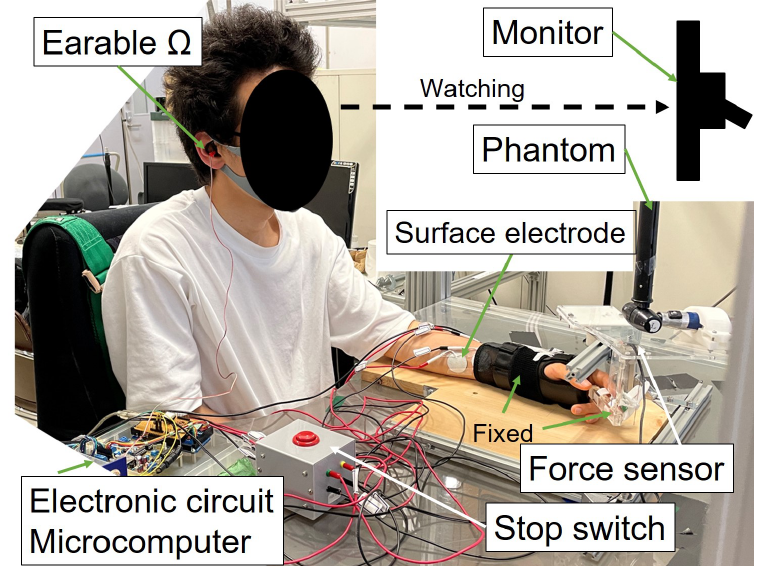
Figure 6. Experimental